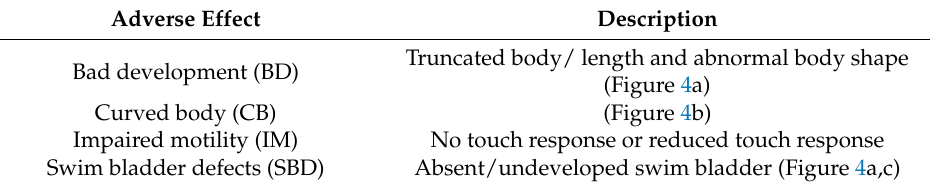
Table 1. Description of sub-lethal toxic effects observed in zebrafish eleuthero embryos at 5